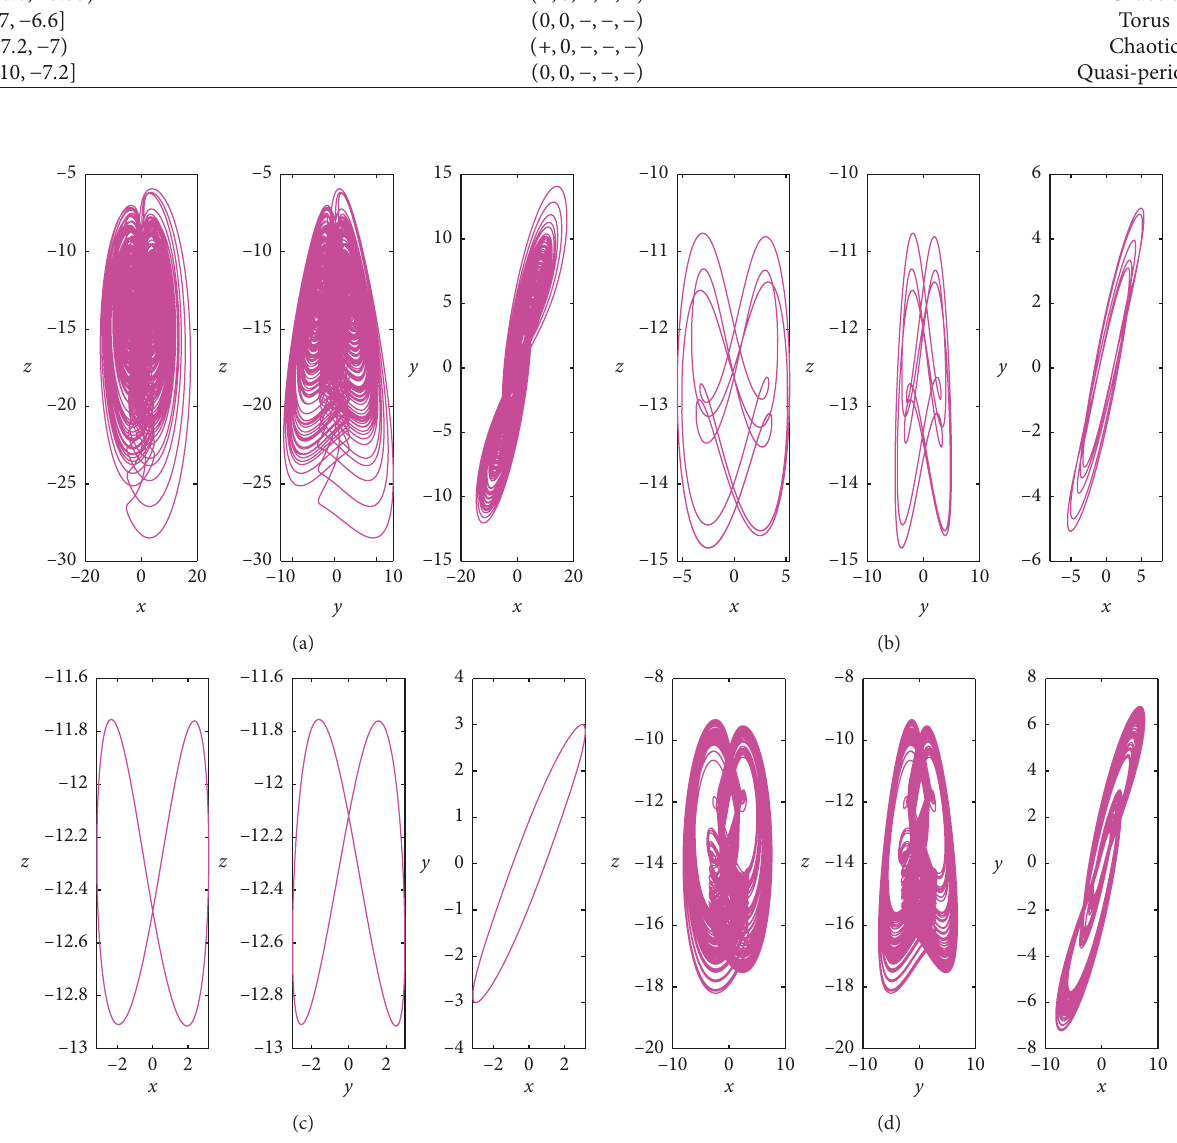
Figure 7: Simulated phase portraits of system (2) with different b : (a) b � − 1, (b) b � − 5, (c) b � − 8, and (d) b � − 6 .